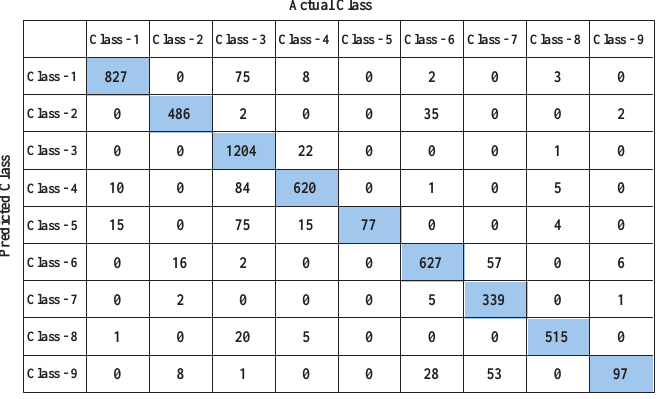
Figure 15. Confusion